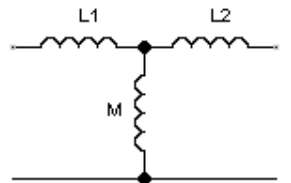
Figure 1. Wireless power transfer (WPT) transformer electric model.